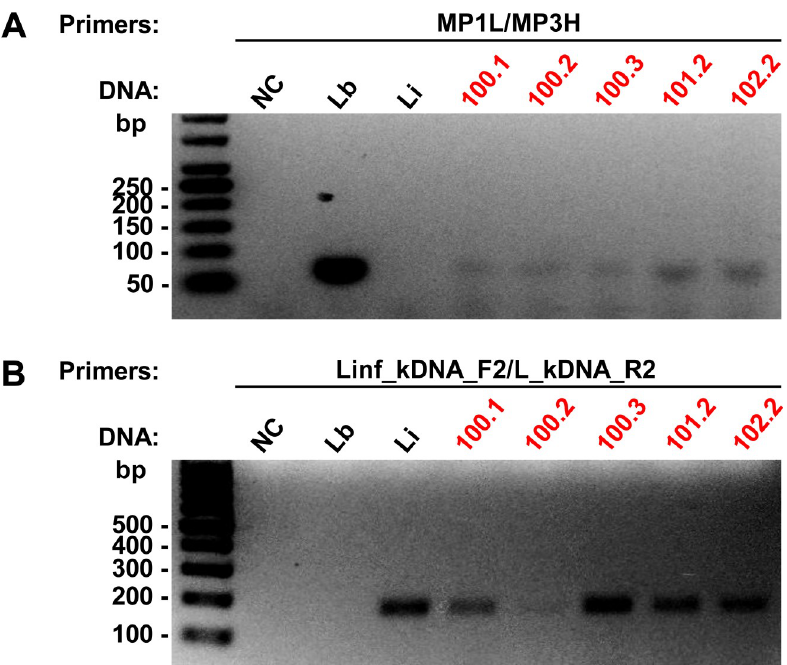
Fig 5. PCR analysis of Lu . longipalpis gDNA coinfected with L . infantum and L . ( Viannia ) spp. Gels of the PCR with the positive samples both for Viannia subgenus, using the primers MP1L/MP3H (fragment: 70 bp) (A) , and for L . infantum , using the primers Linf_kDNA_F2/L_kDNA_R2 (fragment: 183 bp) (B) . Samples marked in red were positive for the respective primers tested. bp: molecular size marker in base pairs; NC: negative control (without DNA); SFN: not infected sand fly; DNA control: Lb: L . braziliensis ; Li: L . infantum .